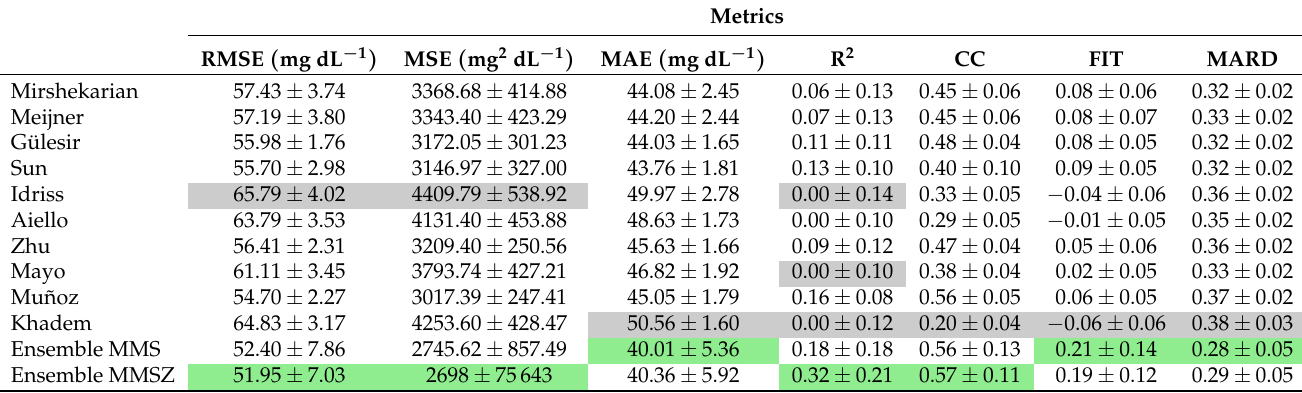
Table 13. Results of the ten NN models for each performance metric for ph = 120min. Green cells in each column highlight the model with the best performance, whereas the grey-colored cells are the